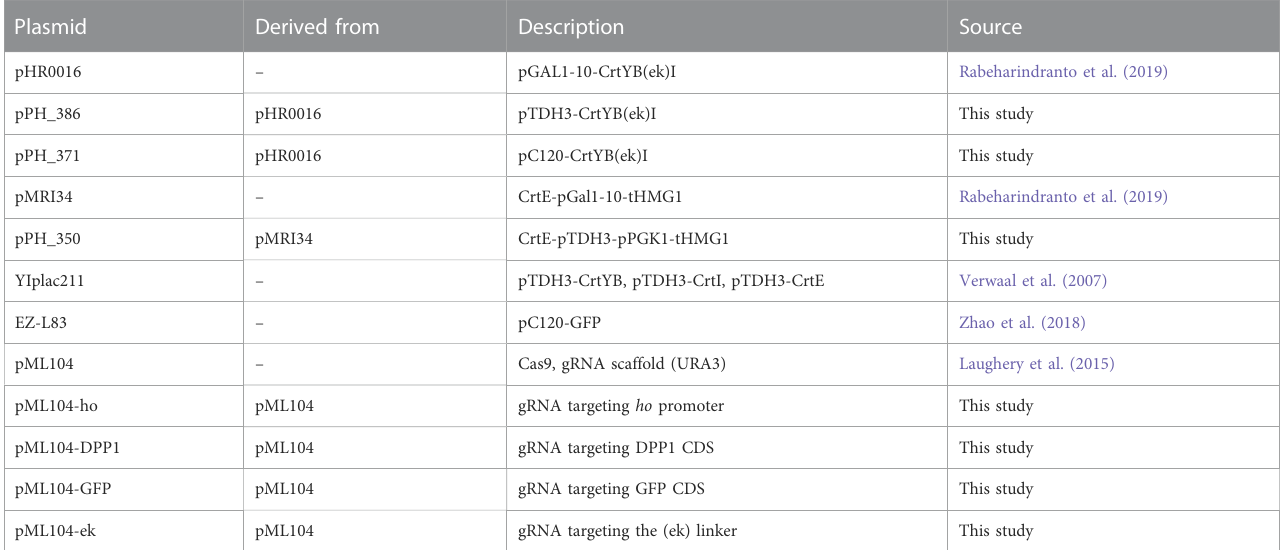
EL222 (constitutive expression of the light-activated transcription EL222 binds to activate the GFP transcription) were inserted at the Δ his3 locus, with a functional HIS3 copy ( Cg HIS3). using (Rabeharindranto et al., 2019) ’ s DNA material in which a trifusion enzyme CrtYBekI was developed. In plasmid pHR0016, the pGal1-10 promoter was replaced with pTDH3 using the Gibson assembly (Gibson et al., 2009), to obtain plasmid pPH_386. Similarly, the bidirectional pGAL1-10 controlling the expression of CrtE and tHMG1 in plasmid pMRI34 was replaced with pPGK1- pTDH3 to build plasmid pPH_350.